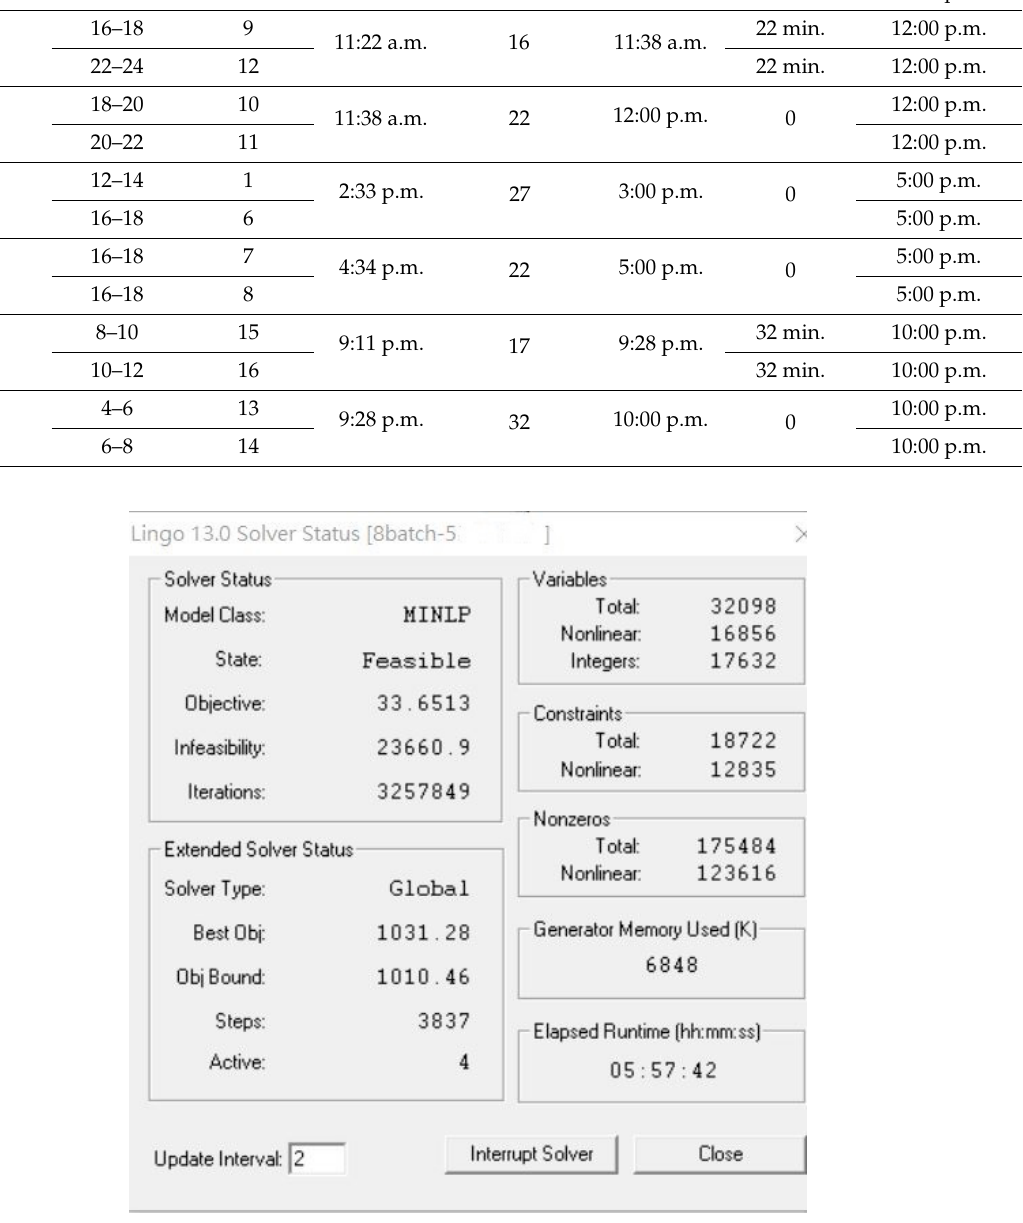
Figure 5. The Screenshot of Lingo solver status.